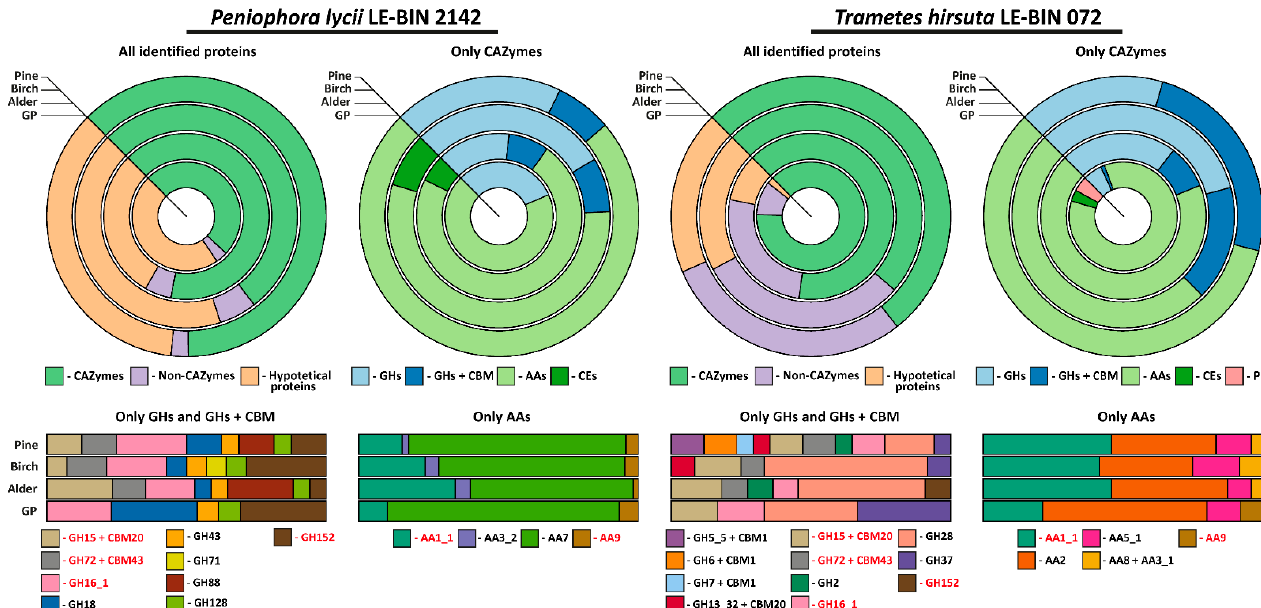
Figure 4. Approximate assessment of the relative quantities of the proteins detected in the exopro- teomes of P. lycii LE-BIN 2142 and T. hirsuta LE-BIN 072 during their semi-solid cultivation on media containing various types of sawdust—alder, birch and pine. The CAZYmes secreted by both fungi are highlighted in red.